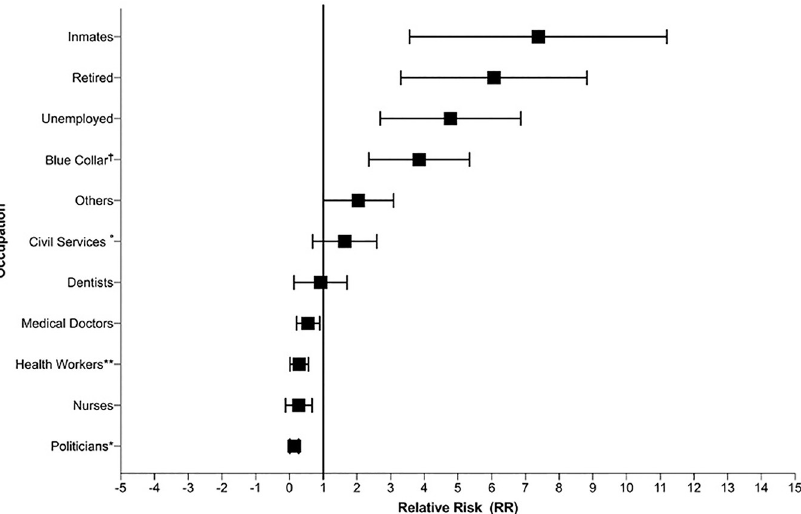
Fig 2. Relative risk calculation by occupation compared with white-collar workers (Engineers, lawyer, auditors, psychologists, chefs, architects, communicator, teachers, managers, chief executive officers, entrepreneurs, analysts, administrator). � Diplomatic, City Mayor, political advisor and city/provincial councilors, �� Hospital and Minister of Public Health administrative personnel, Medical Student nursing assistant, hospital cellars, Medical